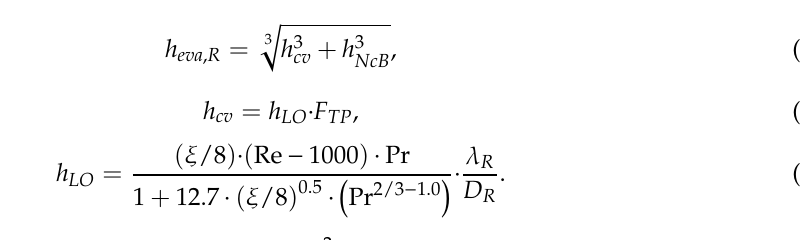
Figure 10. Relationship of SH for given 𝑡 (cid:3035)(cid:3036)(cid:3041) and 𝑝 (cid:3030)(cid:3042)(cid:3048)(cid:3047) .